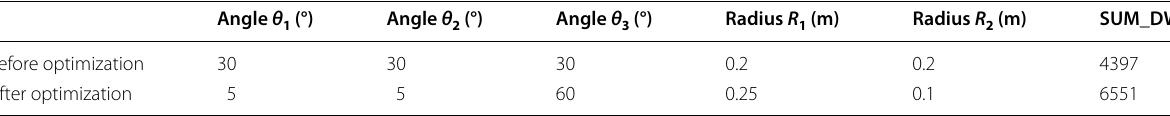
Table 4 Comparison of variables before and after